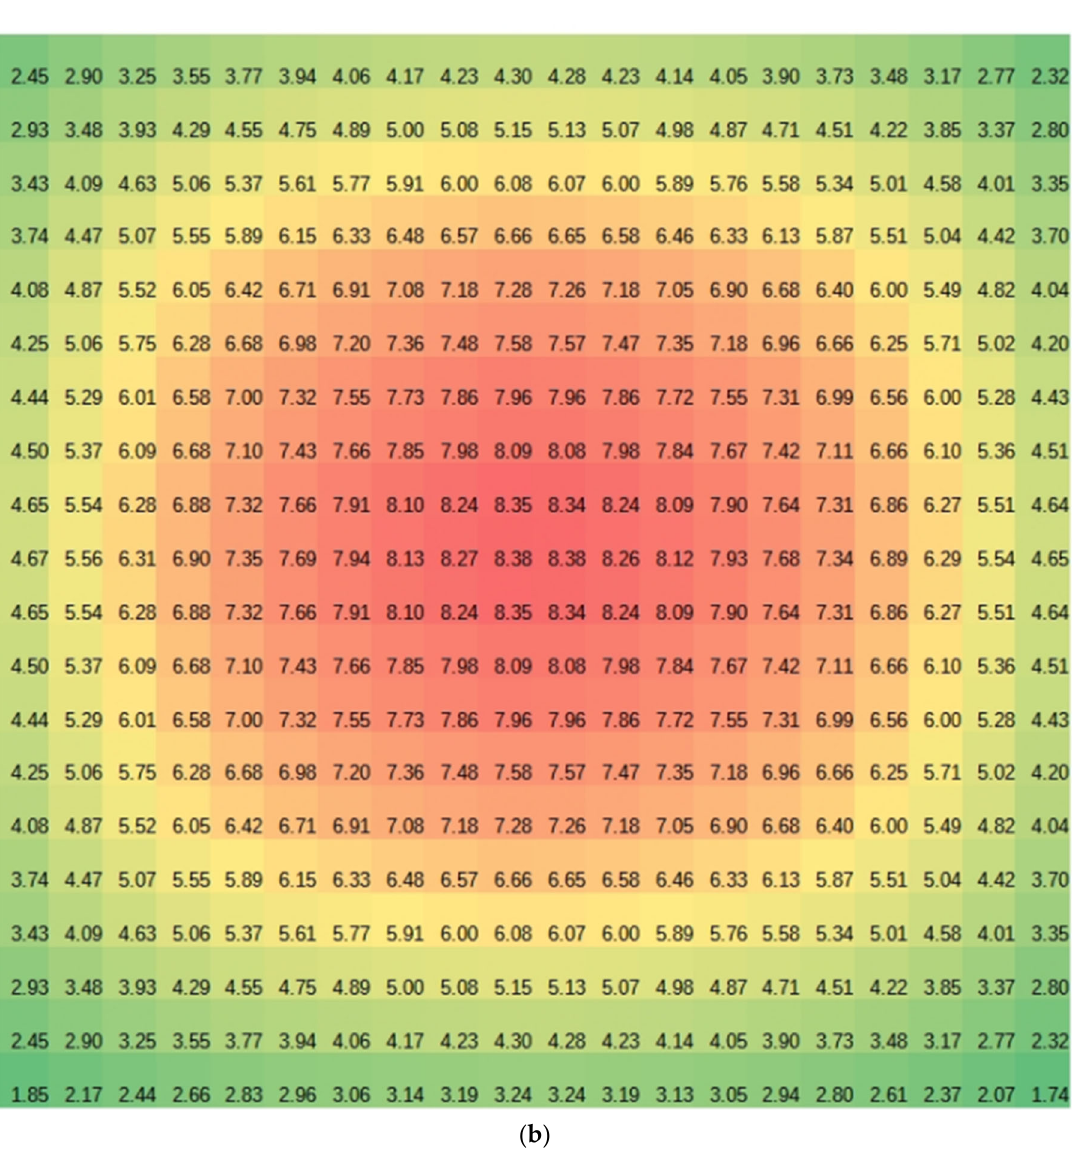
Figure 5. The irradiance S (mW/cm 2 ) at a horizontal plane of (20, 20) cm as emitted by the upper LED array with the LEDs arrangement of Figure 5b, where the plane is ( a ) 4 cm and ( b ) 6 cm away from the upper LEDs array. Table 2. Average irradiance S (mW/cm 2 ) in a single UVC chamber passage of 10 cm height of Figure 5. Distance from Top LED Plate (cm)